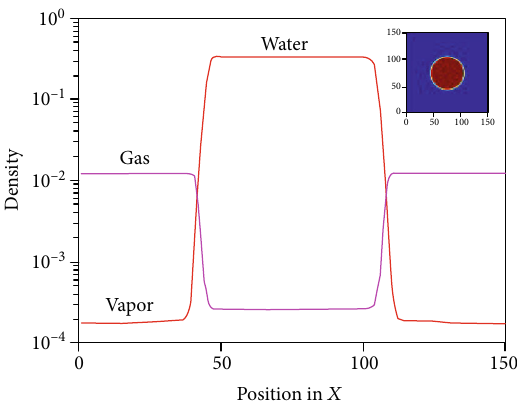
Figure 3: The density distributions of methane and water along the centerline of a water droplet.